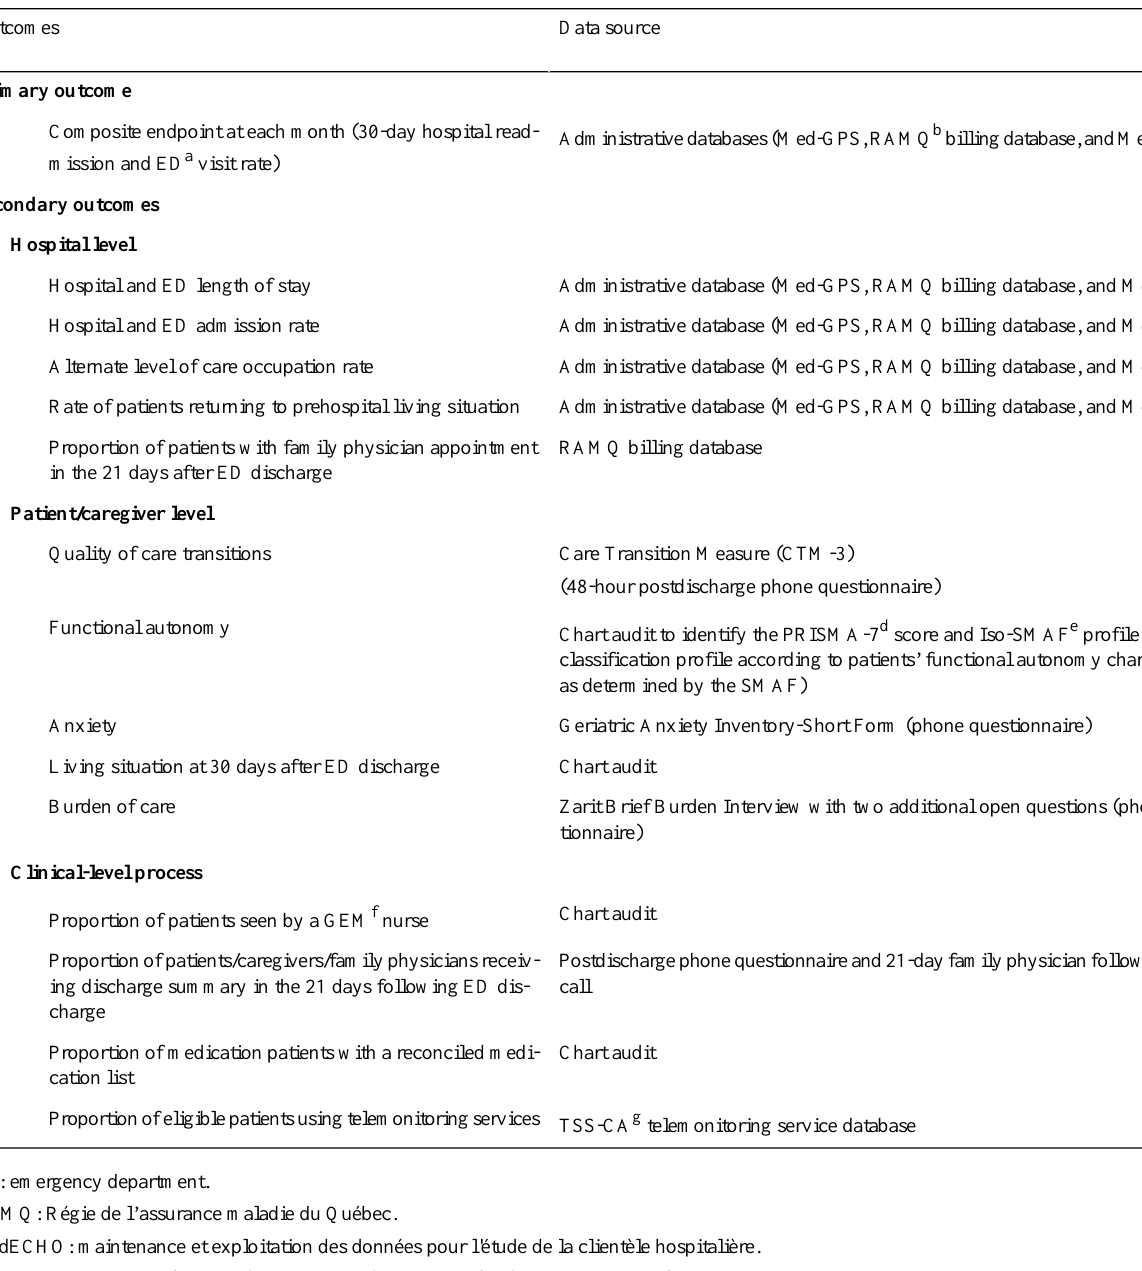
Table 1. Primary and secondary study